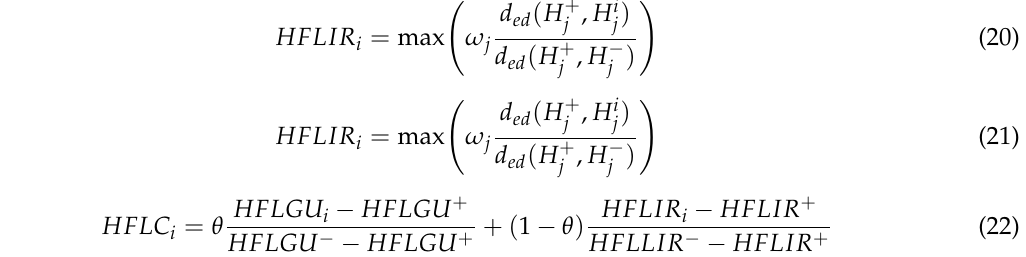
( i = 1, 2, 3, 4 ) , HFLIR